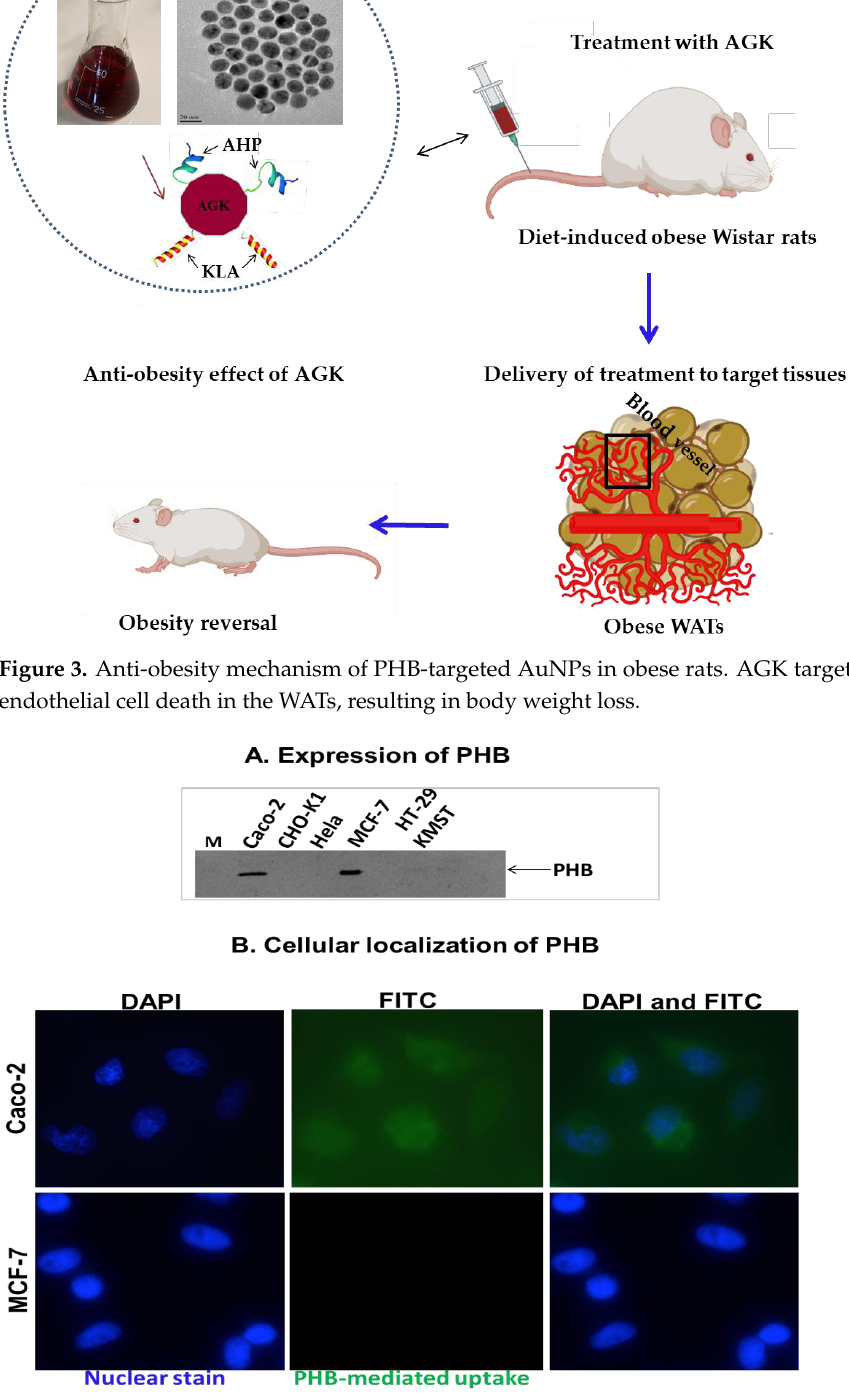
Figure 4. Western blot ( A ) and cytochemistry ( B ) analyses of PHB expression [10] in humans (Caco-2, HeLa, MCF-7, HT-29, and KMST-6) and Chinese Hamster Ovary cells. Expression of PHB was detected only in Caco-2 and MCF-7 cells ( A ). Fluorescent microscopy revealed uptake of AHP-Fluorescein isothiocyanate (AHP-FITC) by Caco-2 cells, indicating expression of PHB on the cell surface. No AHP-FITC fluorescent was observed in MCF-7 cells, which indicates that the PHB receptor is not on the cell surface. Reproduced with permission from Future Medicine Ltd. [10]. Immunocytochemistry analysis proved that the Caco-2 cells expressed PHB on the cell surface, while the MCF-7 cells expressed it in the cytoplasm (Figure 4B). The Caco-2 cells are human epithelial colorectal adenocarcinoma cells, while the MCF-7 cells are epi-